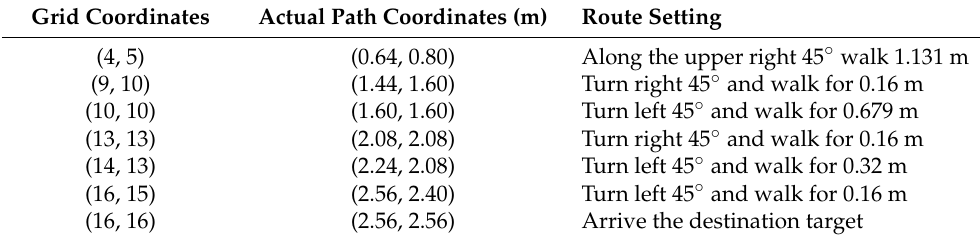
Table 2. Path setting for the NAO